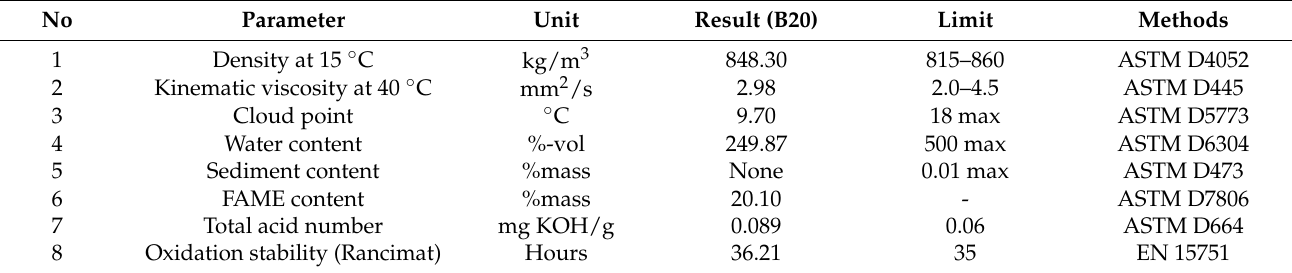
Table 5. B20 specification and quality.